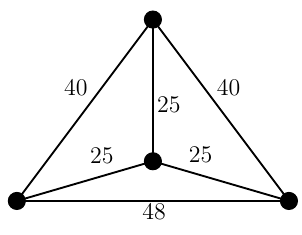
Figure 4: The smallest tetrahedron graph with equal inner